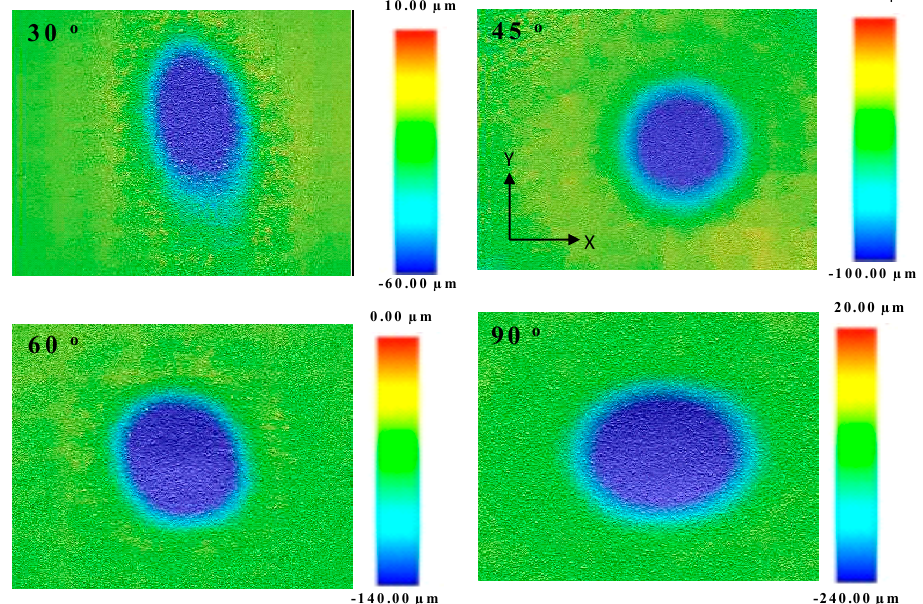
Figure 3. Representative optical profilometry of API X120 steel eroded surfaces at four different impact angles at particle speed 167 m·s − 1 . X and Y directions are shown, Z direction is vertically down. Features shown here are not to the scale.